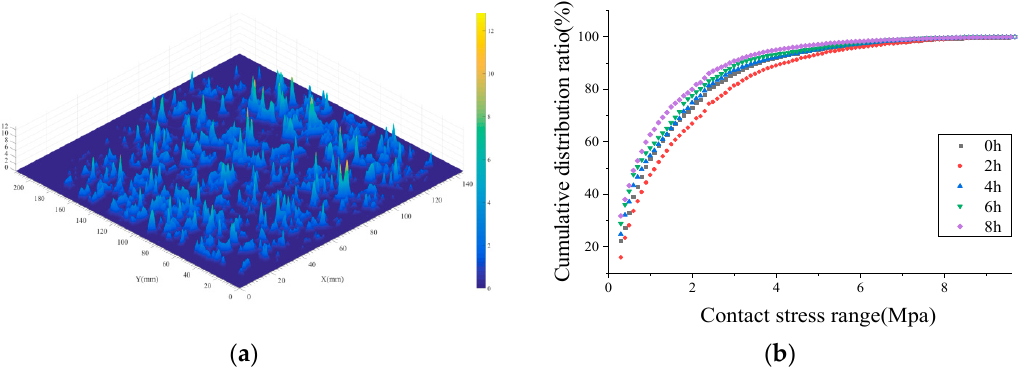
Figure 8. Attenuation of contact stress distribution: ( a ) initial contact stress distribution map and( b ) cumulative contact stress distribution.